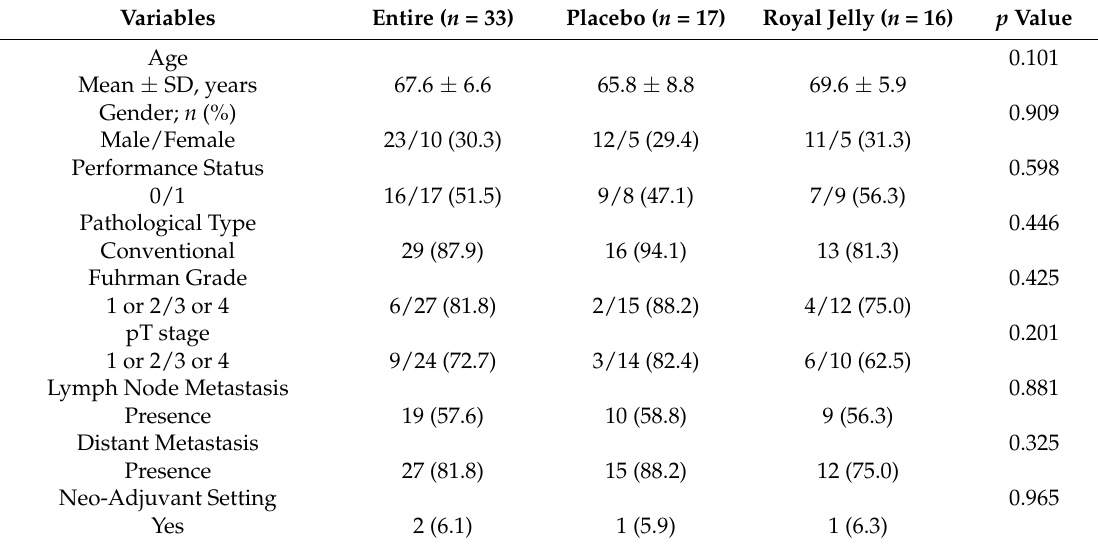
Table 1. Clinicopathological features and basic